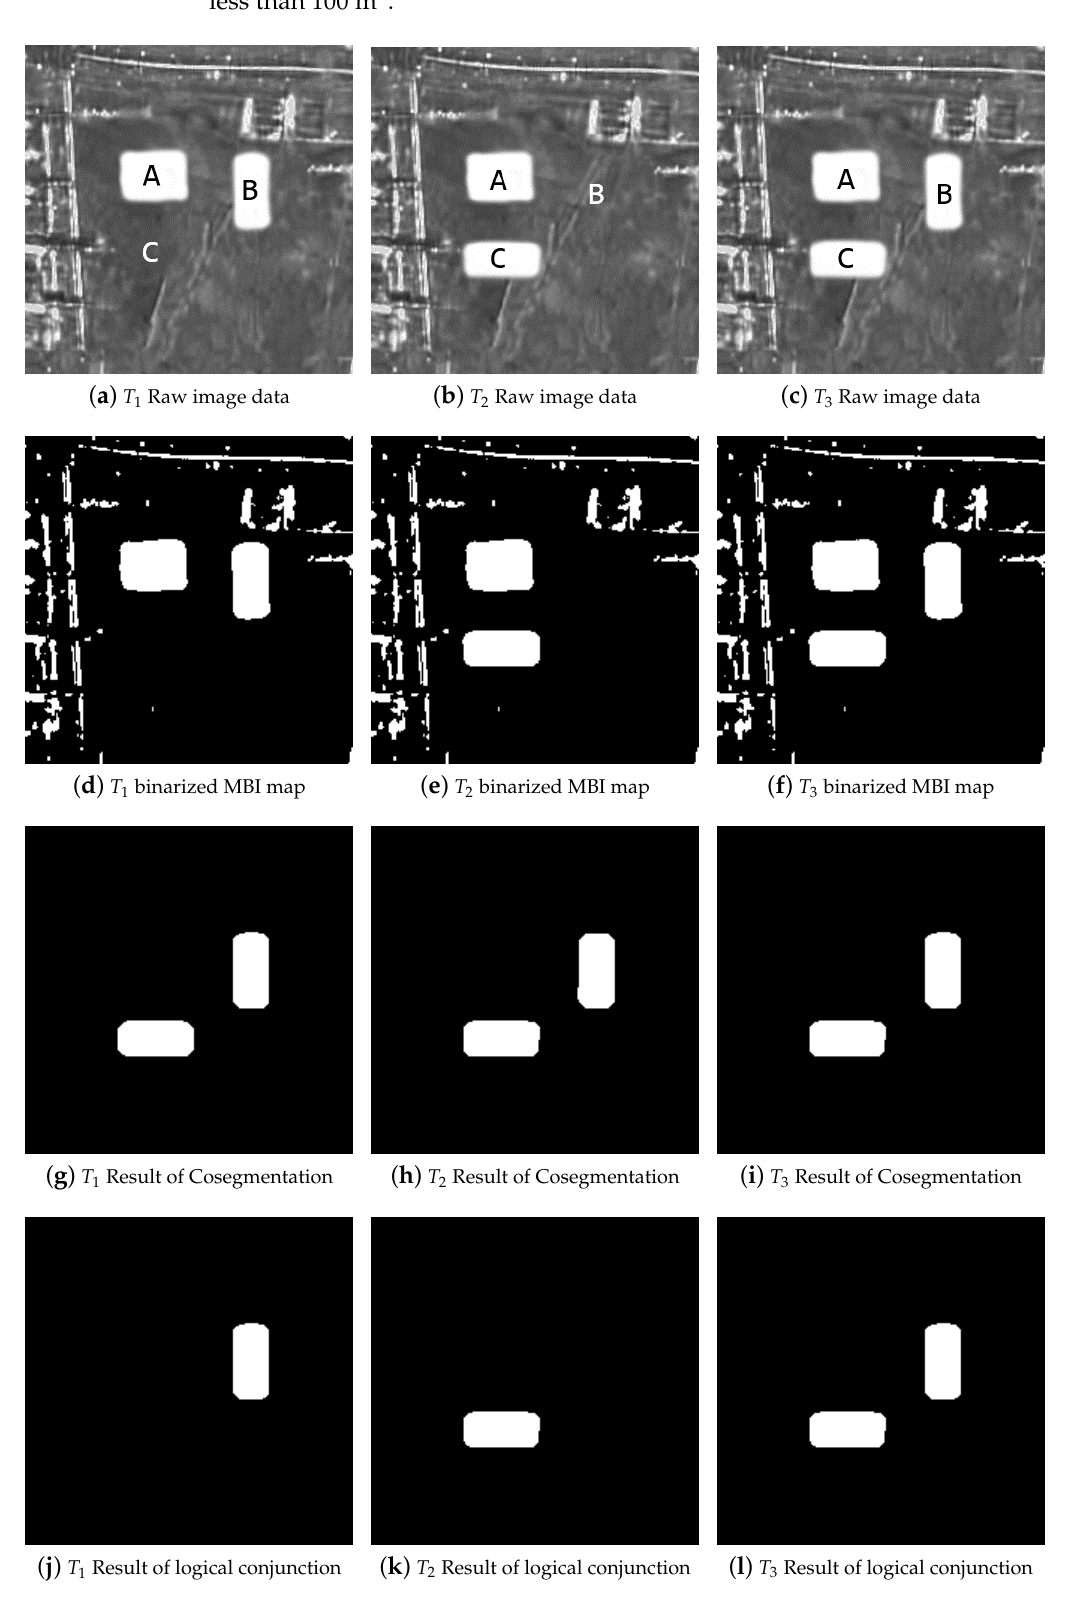
Figure 4. Synthetic data. For contrast, we test three regions, names A, B, and C. The building in region A did not change. The building in region B was demolished on time 2, and a new building was constructed on time 3. The building in region C was constructed on time 2 and did not change on time